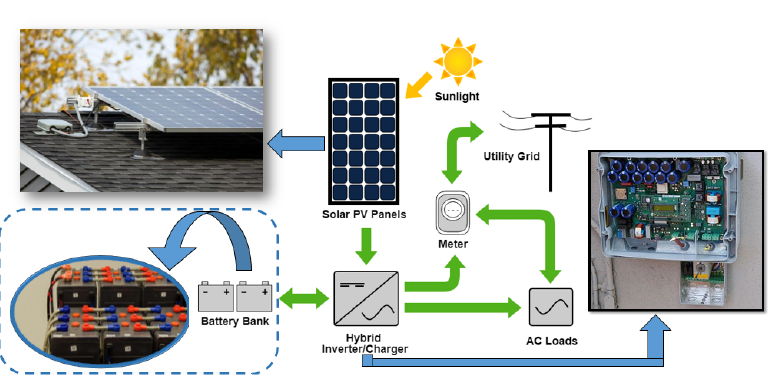
Figure 1. Main structure of a PV